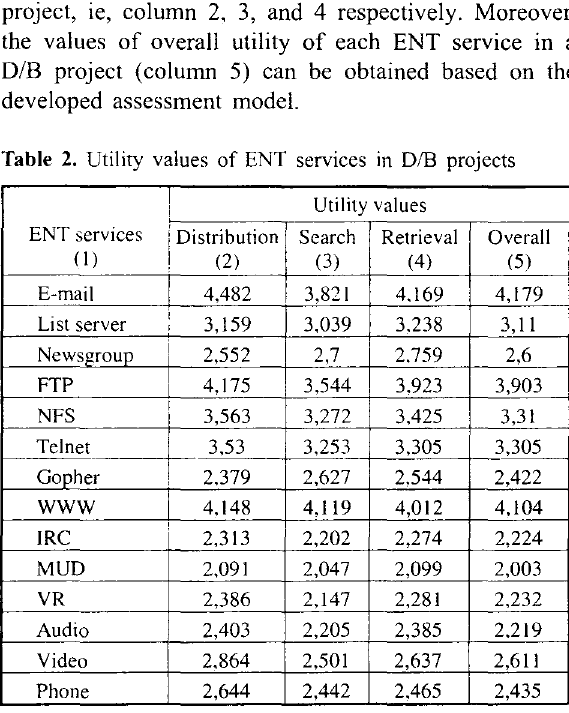
Table 2. Utility values of ENT services in D/B projects